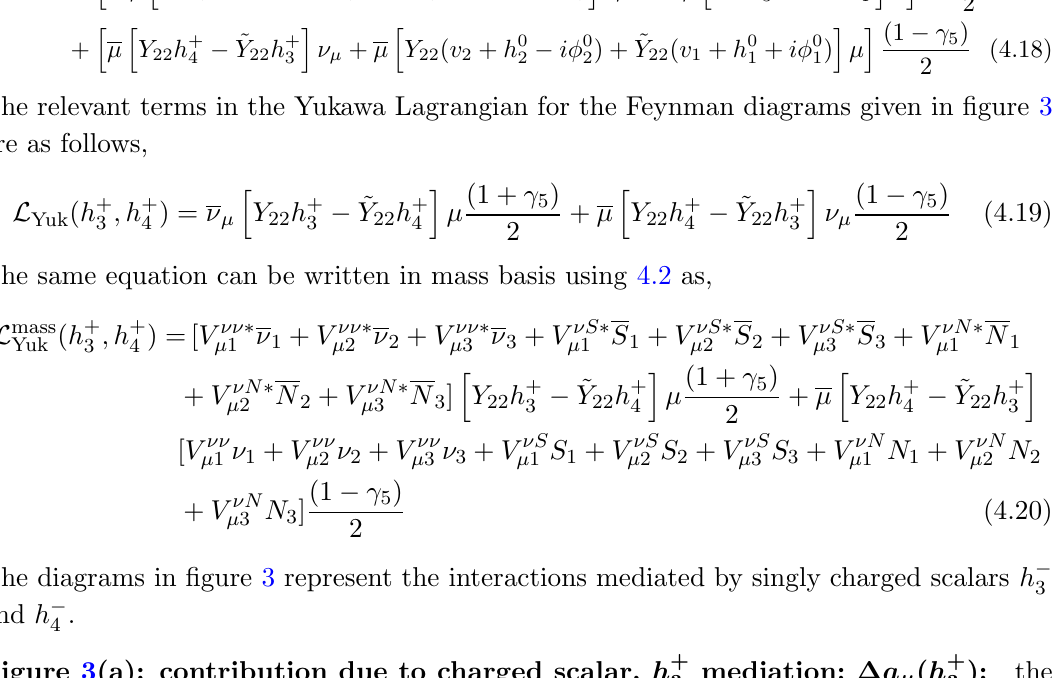
Figure 3(a): contribution due to charged scalar, h +